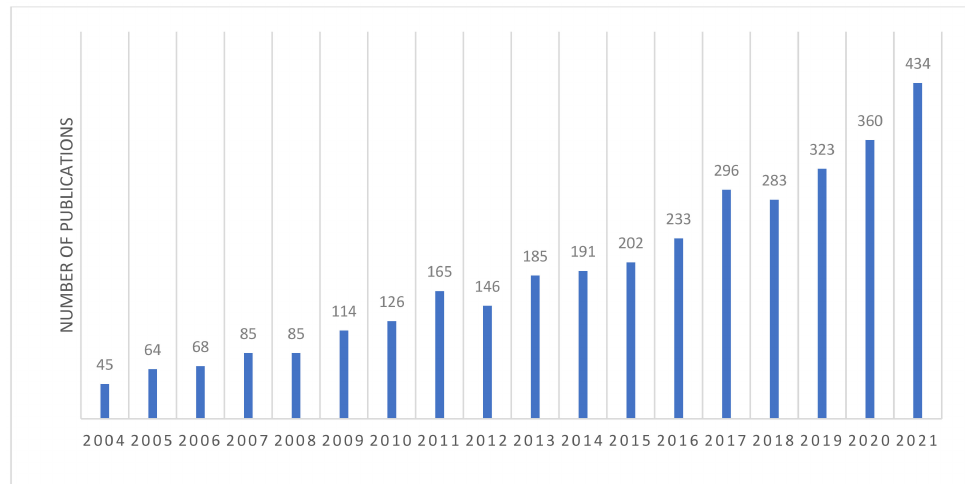
Figure 1. Number of articles regarding air pollution governance published in past